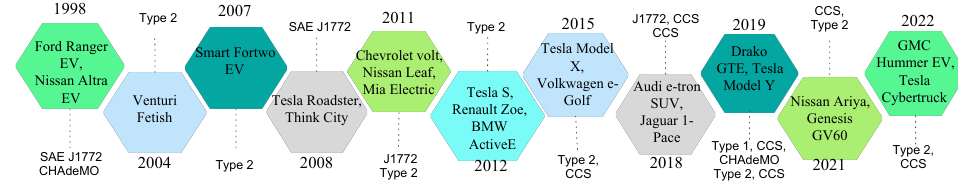
Figure 1. Evolution of